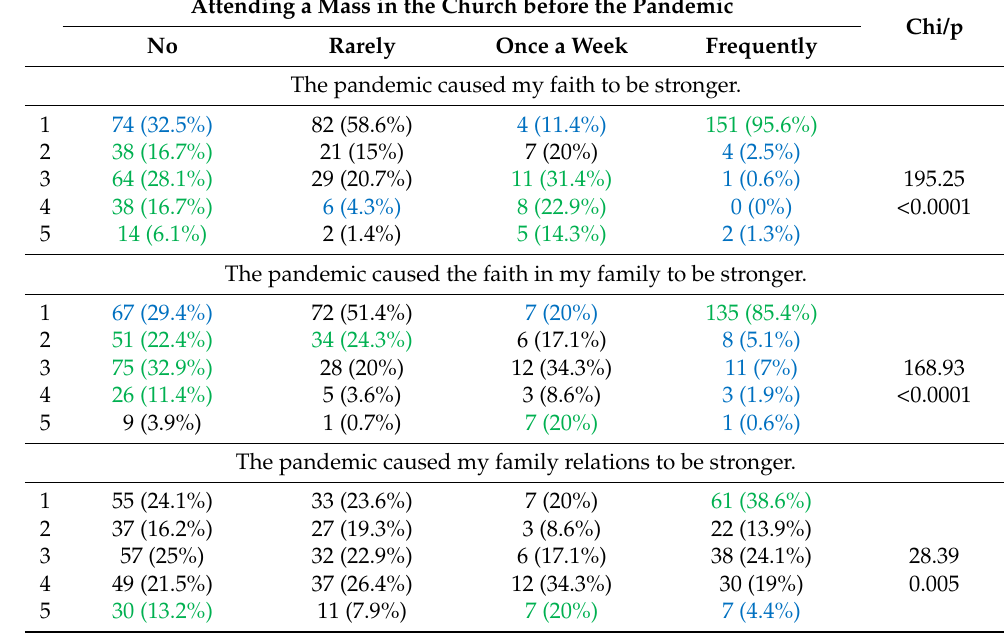
Table 3. Comparison of responses to questions about religion, the pandemic, and health issues between high school students depending on their religious